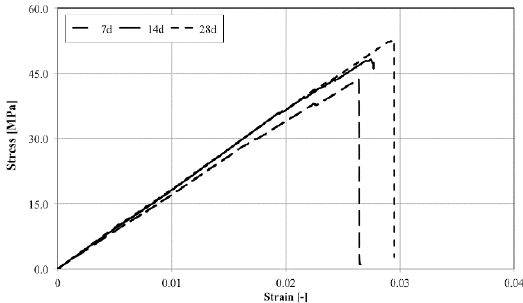
Figure 6. Compression stress vs. strain at different aging period (PEG 6 wt%).